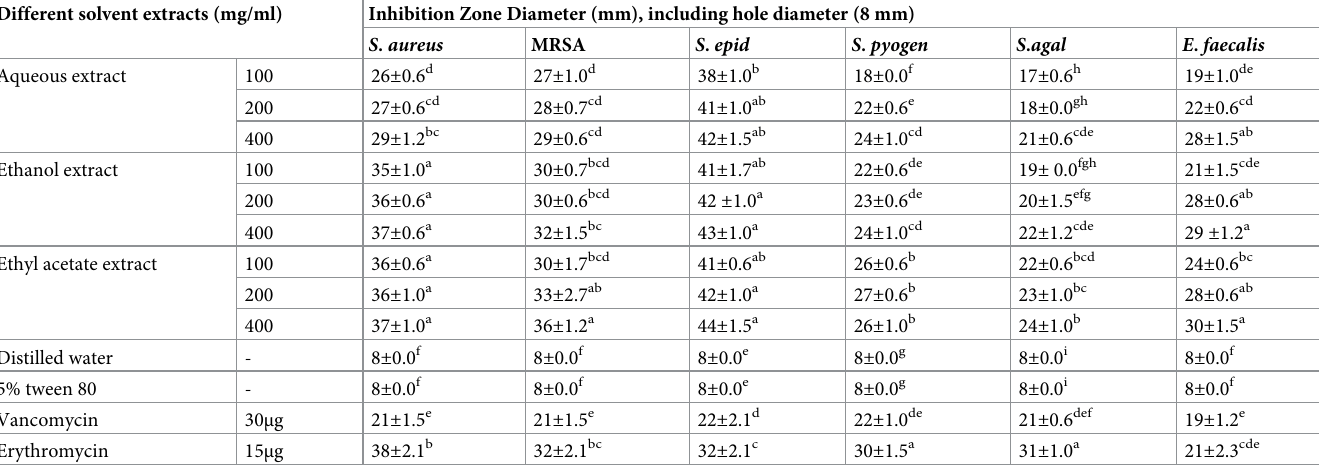
Table 1. Inhibition zone diameter measurement (mm) of crude extracts of I . tinctoria A. Rich roots against gram-positive bacteria. Different solvent extracts